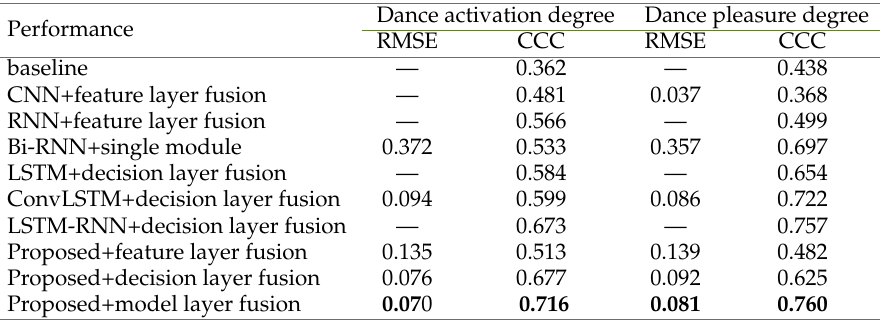
Table 3. Comparison of our experiment with other paper